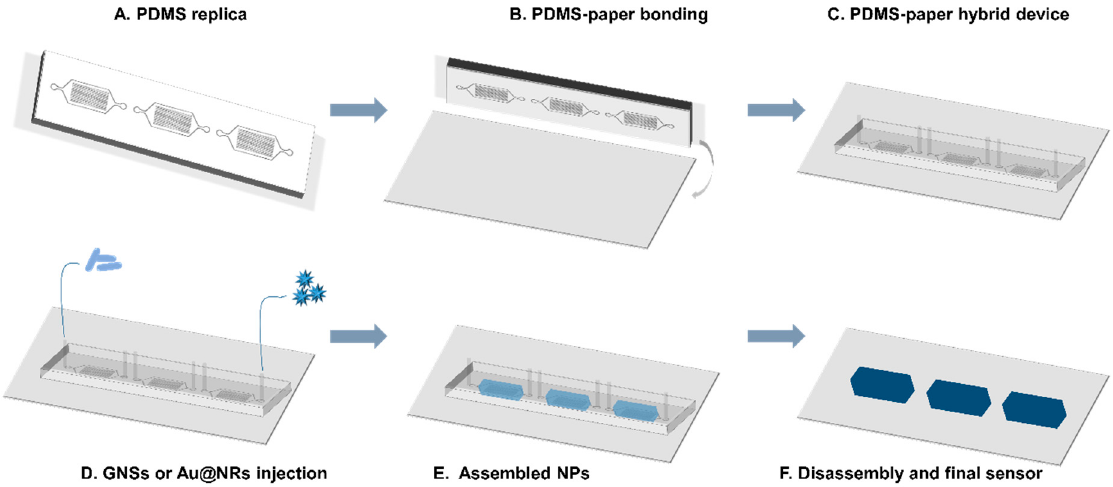
Figure 2. Schematic representation of the fabrication of the hybrid PDMS-paper device ( A – C ) injection and self-assembly of the NPs ( D ) Raman model molecule or lysed cells injection ( E ) final disassembly of the paper sensor for analysis ( F ).